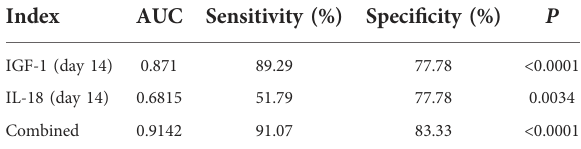
TABLE 4 The diagnostic value of IGF-1 combined with IL-18 for predicting